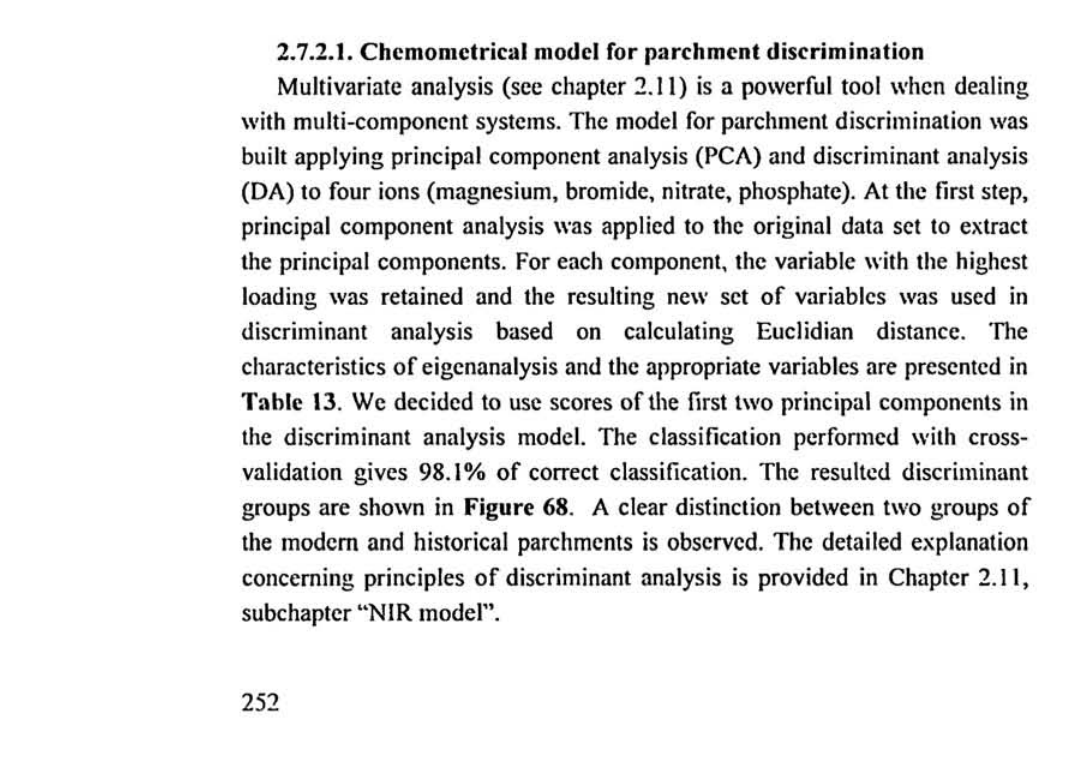
Fig. 67: Markers for fast identification of ancient